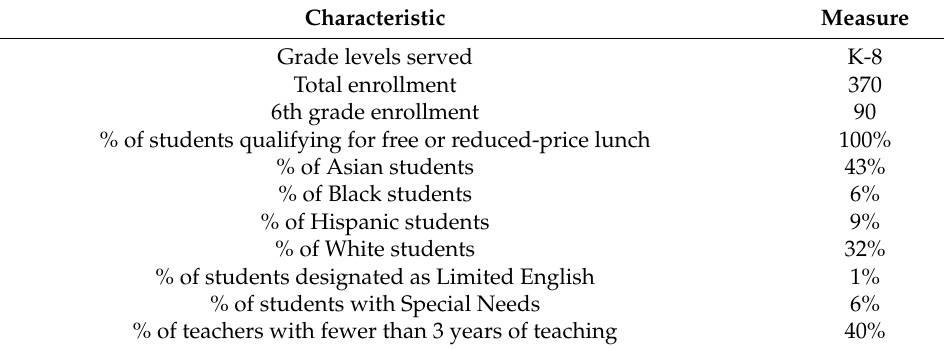
Table 2. Summary of Avenue School